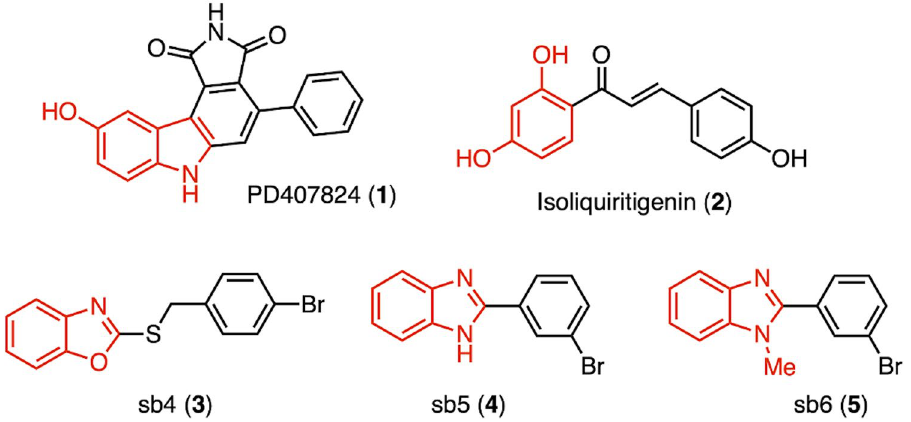
Figure 1. Reported small molecules that act as activators/partial agonists of BMP receptor-associated signaling. The figure illustrates the chemical structures of known BMP modulators. Images are modified from Feng et al . (compound 1 ), Vrijens et al . (compound 2 ) and Bradford et al. (compounds 3 , 4 and 5 ). Compounds 1 , 3 , 4 , and 5 are synthetic molecules, while compound 2 is a natural product 13,22,23